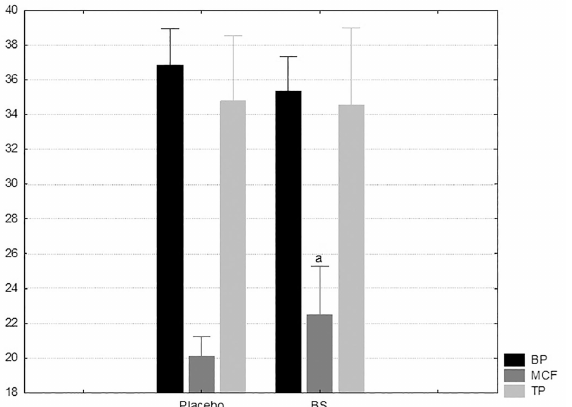
Figure 1 - Total number of repetitions with or without supplementation (Data are mean ± SD). BP = Bench press; MCF = Machine chest fly; TP = Triceps pushdown ; BS = Bicarbonate supplementation; a Large mag- nitude difference between supplementation condition (d >